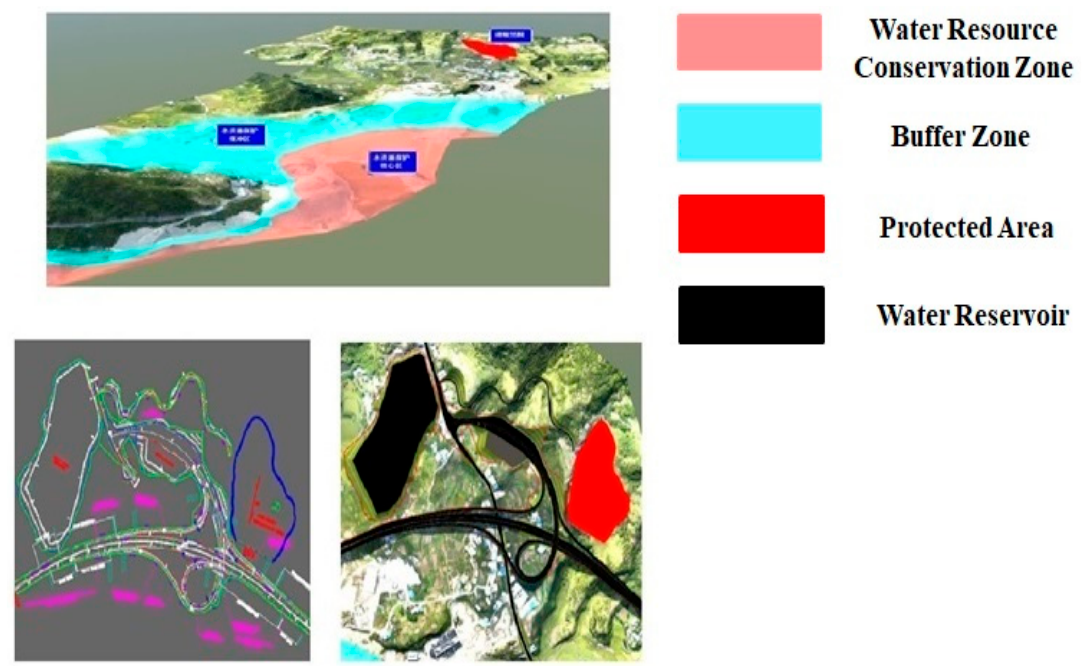
Figure 12. Environmental analysis of the highway project.